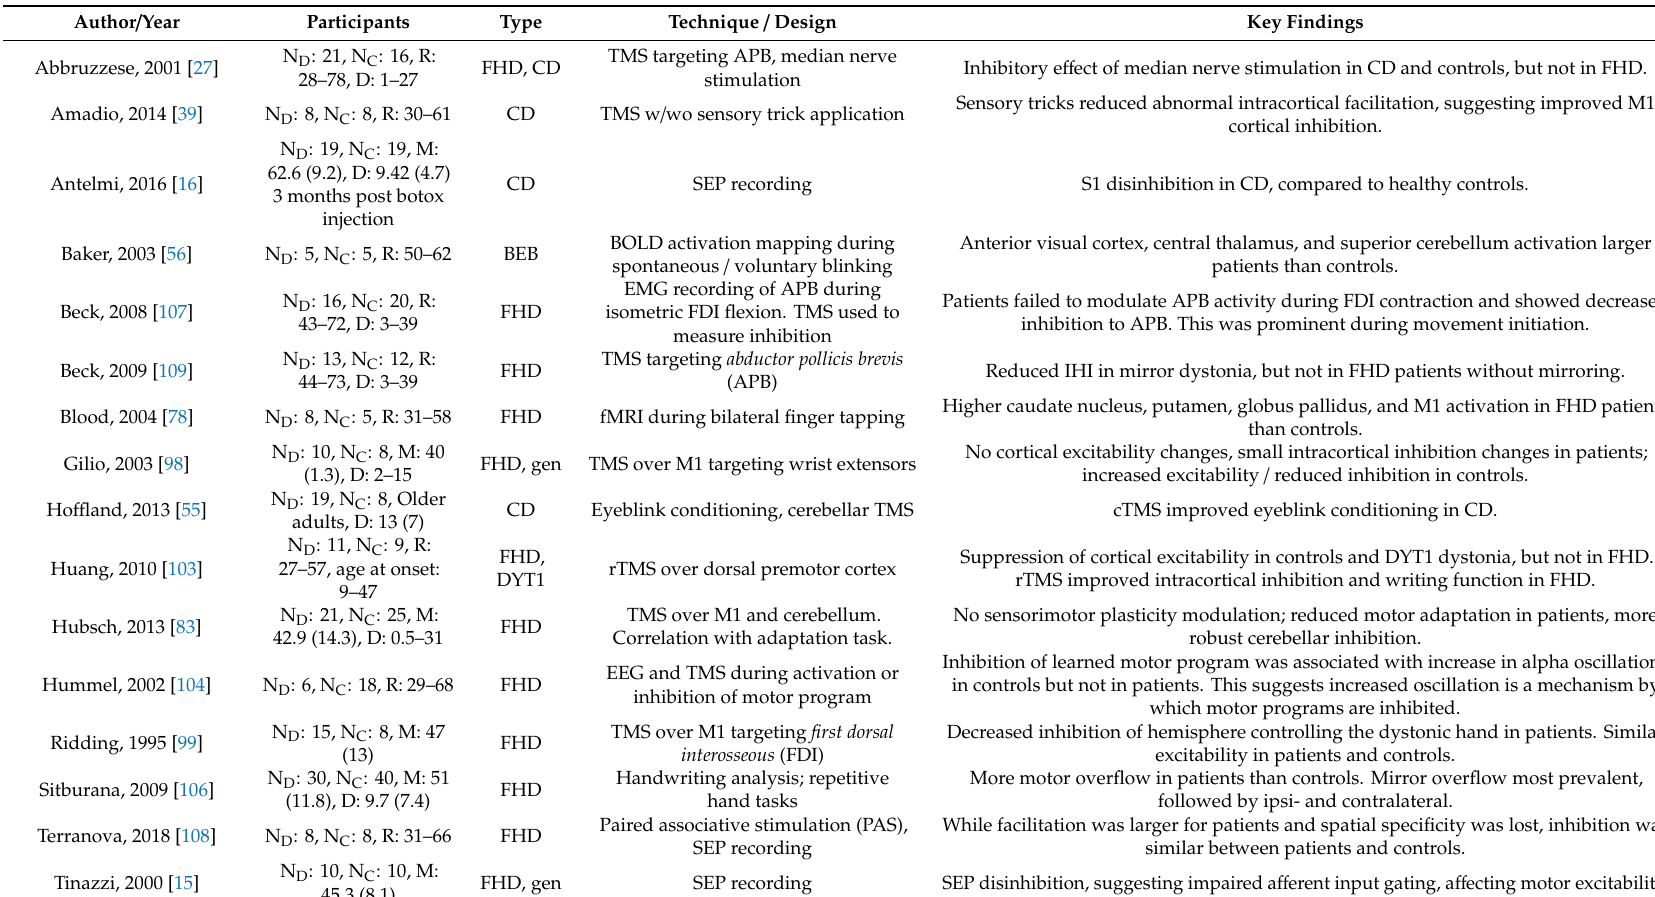
Table 2. References addressing cortical inhibition / excitation in patients with focal hand dystonia (FHD), cervical dystonia (CD), benign essential blepharospasm (BEB), generalized (gen), or DYT1 dystonia (DYT1). The number after the year reflects position in the reference list. Under Participants, N D and N C respectively denote dystonia and control sample sizes, R denotes age range, M denotes mean (standard deviation), and D denotes duration of symptoms, all in